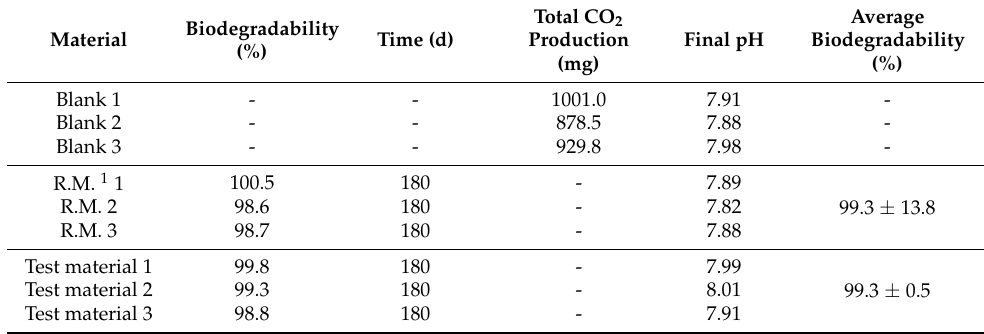
Table 18. Main biodegradability test results.